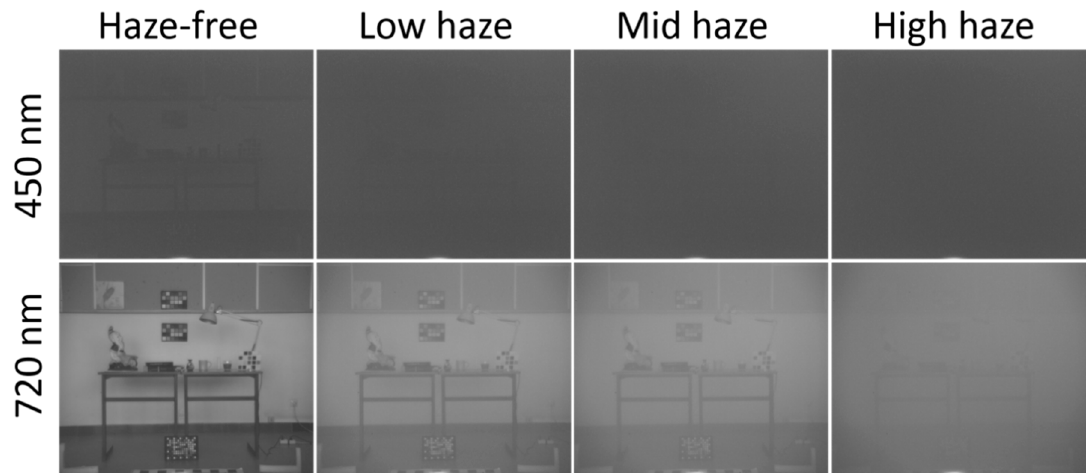
Figure 1. Example images from the spectral hazy image database for assessment (SHIA) [17], at two different wavelengths and four different levels of haze.